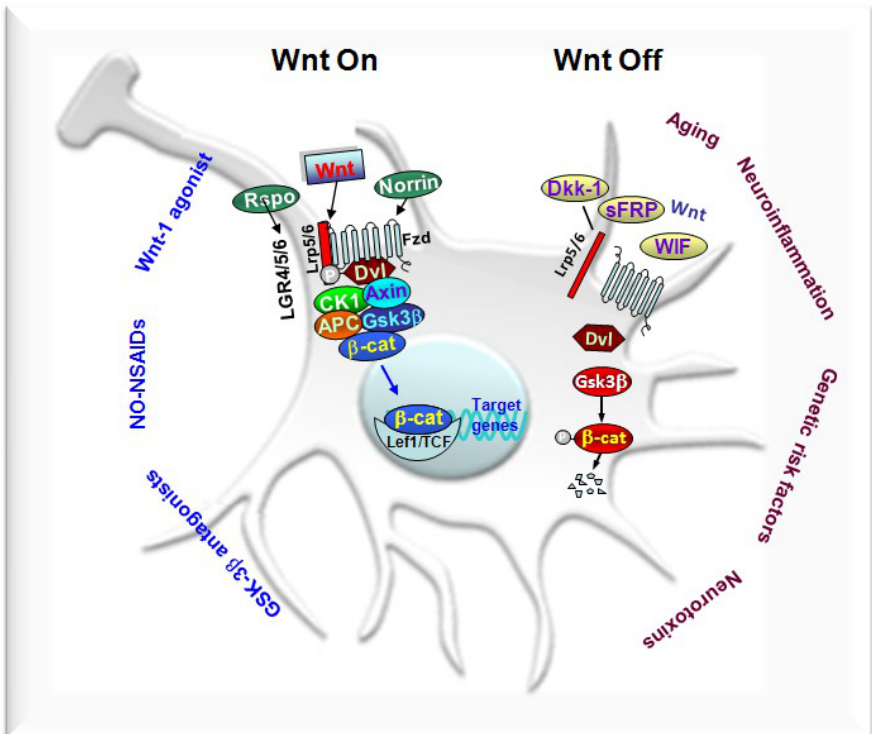
Figure 2. Schematic illustration of Wnt1/ β -catenin signaling regulation of midbrain dopaminergic (mDAergic) neuron survival/death according to our published findings [49–57]. Major environmental factors including aging, inflammation, and 1-methyl-4-phenyl-1,2,3,6-tetrahydropyridine (MPTP) exposure may increase oxidative load and a panel of endogeneous Wnt antagonists (Dickkopf1 (Dkk1), Wnt inhibitory factor (WIF), frizzled-related proteins (sFRPs)) that, in synergy with genetic mutations and dysfunctional glia–neuron interactions, antagonize canonical Wnt/ β -catenin signalling (“Wnt off”) in mDA neurons. Upregulation of active GSK-3 β then leads to β -catenin degradation promoting DA neuron death. In the presence of canonical Wnt1-like agonists (such as R-spondin (Rspo) or Norrin), GSK-3 β antagonists, or nitric oxide non-steroidal anti-inflammatory drug (NO-NSAID) treatments, activation of Wnt/ β -catenin (“Wnt on”) contributes to maintaining the integrity of mDA neurons via blockade of GSK-3 β -induced phosphorylation and proteasomal degradation of the neuronal pool of β -catenin. β -catenin then translocates into the nucleus and associates with a family of transcription factors regulating the expression of Wnt target genes involved in mDAergic neuron survival. Schematic drawing based on published results on Wnt signaling in PD